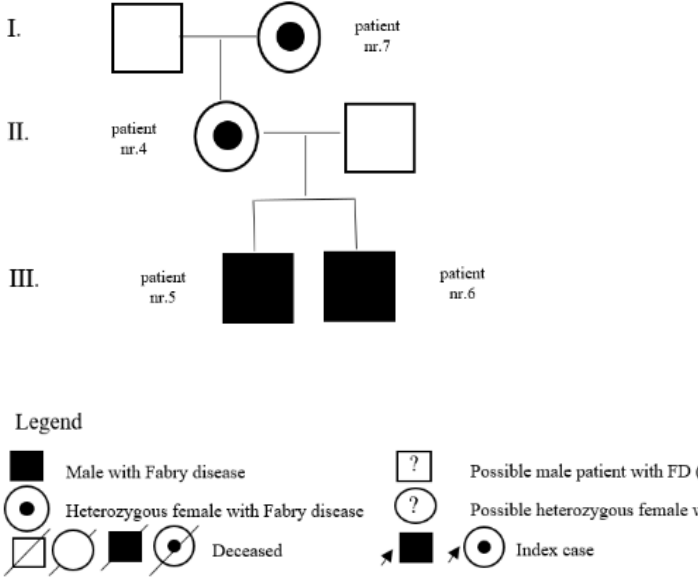
Figure 1. Pedigree of family with mutation c.128G>A.